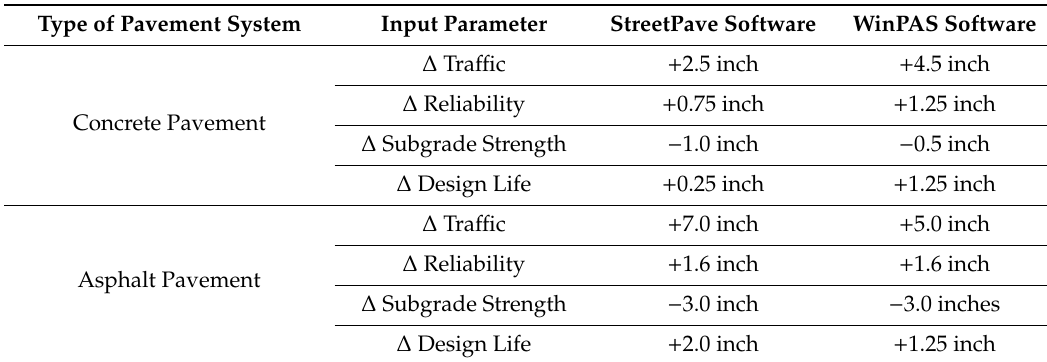
Table 4. Comparisons of sensitivity analysis results using StreetPave and WinPAS software.